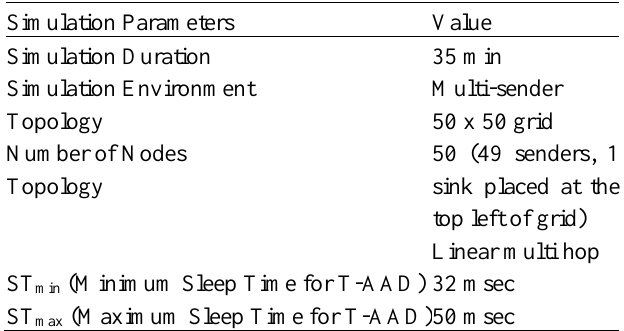
Simulation Settings for Comparing ADP-MAC with